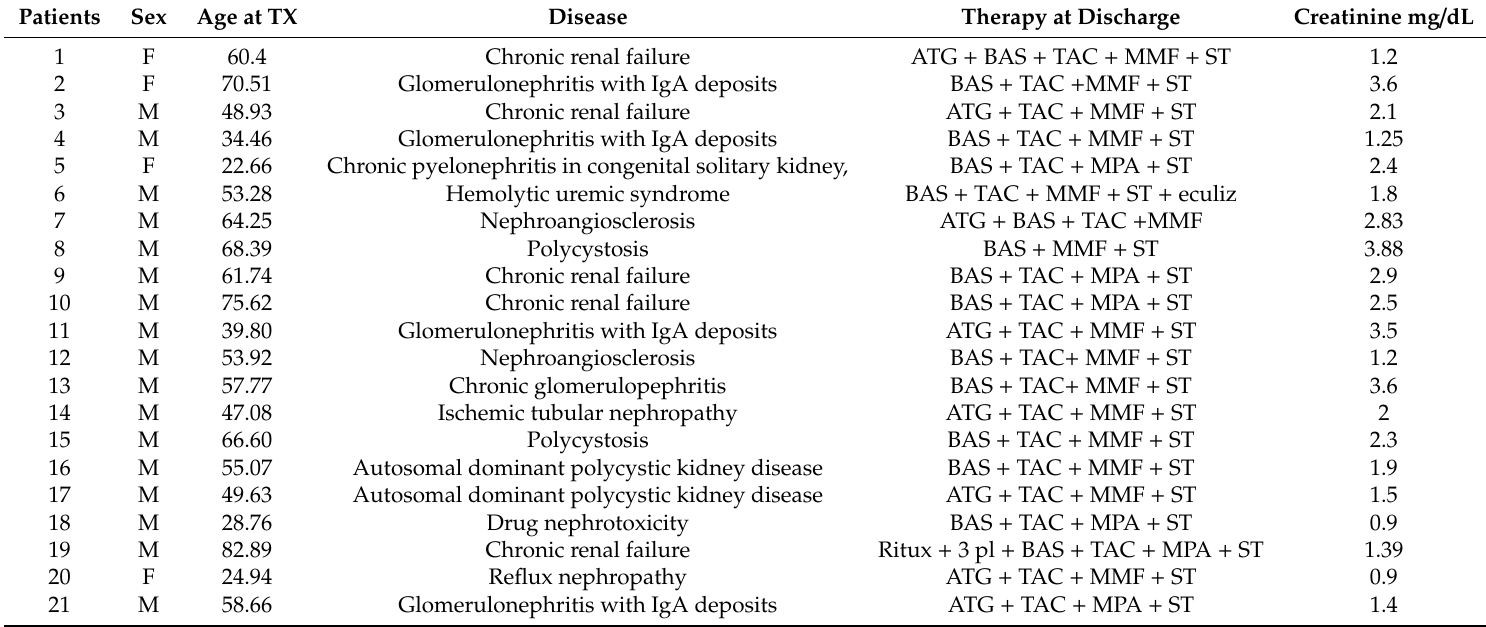
Table 2. Demographic, clinical, and therapeutic features of study patients. Anti-thymogobuline (ATG), Basiliximab (BAS), Tacrolimus (TAC), mycophenolate mofetil (MMF), mycophenolate (MPA), steroids (st), eculizumab (eculiz), rituximab (ritux), plasmapheresis